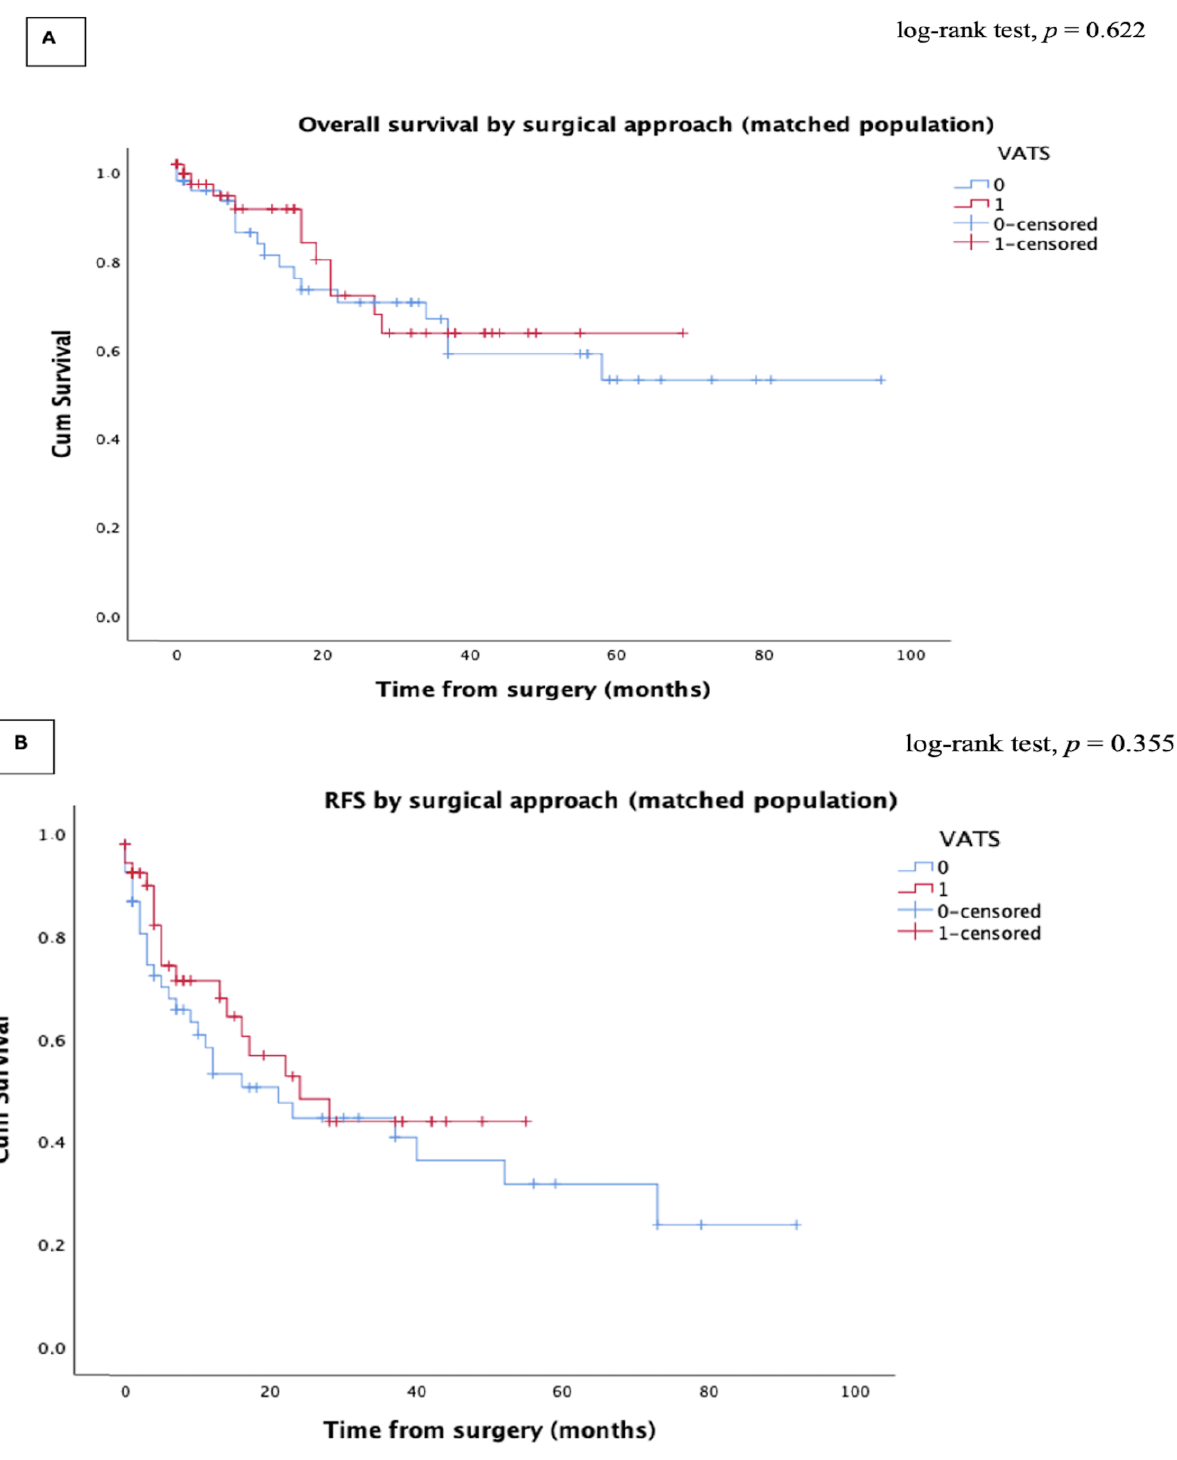
Figure 2. Kaplan–Meier curve for long-term survival after propensity score matching (PSM). ( A ) Over- Figure 2. Kaplan – Meier curve for long-term survival after propensity score matching (PSM). ( A ): all survival; ( B ) Recurrence-free survival. VATS: Video-assisted thoracoscopic Overall survival; ( B ): Recurrence-free survival. VATS: Video-assisted thoracoscopic surgery The multivariable-adjusted survival analysis revealed that sex (HR, 0.349; 95% CI, 0.134 – 0.911; p = 0.031) and pathologic TNM stage (HR, 1.092; 95% CI, 1.050 – 1.136; p < 0.001) were independent predictors of worse RFS, but the VATS approach was not (HR, 2.359; 95% CI, 0.946 – 2.883; p = 0.066; Table 5) Table 5. Multivariable Cox proportional hazards analyses for RFS. Characteristics